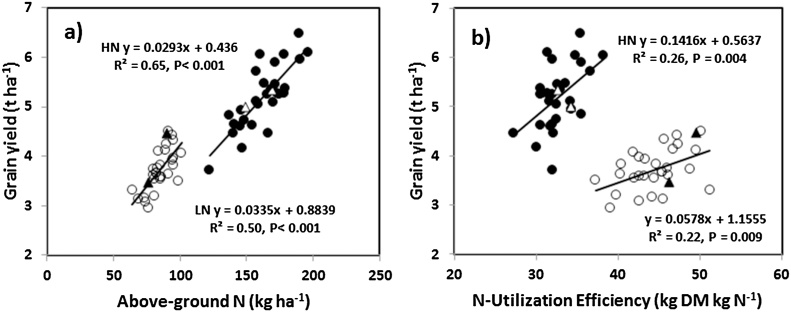
Linear regression of grain yield (100% DM) on (a) N uptake at harvest and (b) N-utilization efficiency (NUtE) under high N (HN) and low N (LN) conditions for 30 Indian wheat cultivars. Values are means of 2013-14 and 2015-16) (bread wheat cultivar HN ●; durum wheat cultivar HN Δ; bread wheat cultivar LN ○; durum wheat cultivar LN ▲).